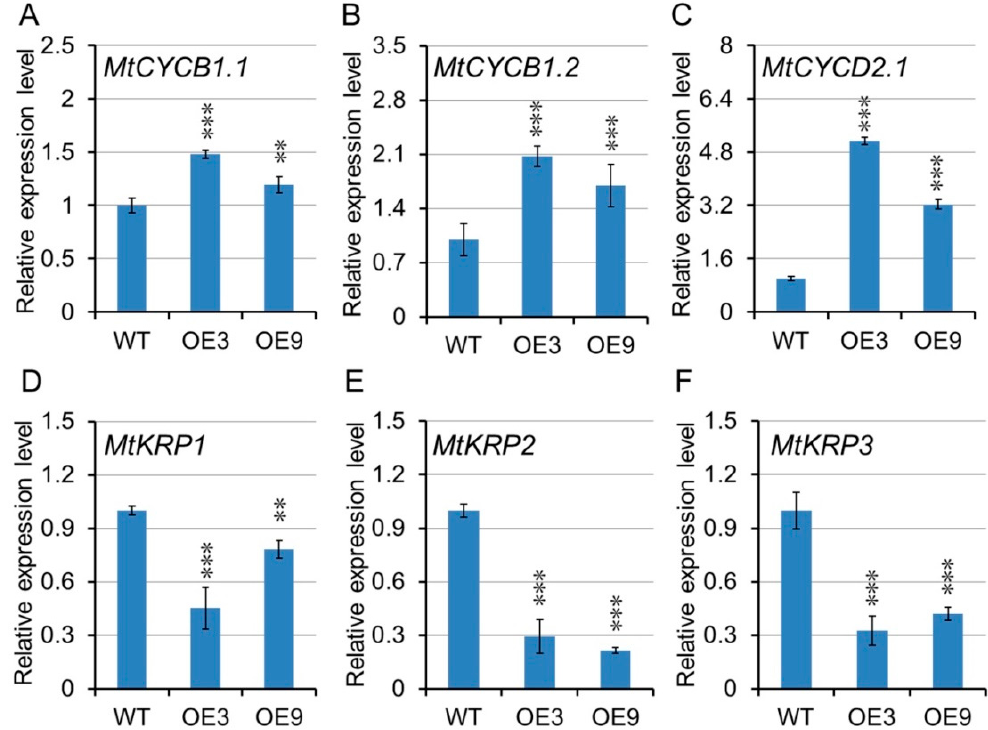
Figure 10. Expression analysis of cell development related genes in wild-type and MtGA20OX1 transgenic lines. ( A – C ) The expression of cyclindependent protein kinase genes, MtCYCB1.1 , MtCYCB1.2, and MtCYCD2.1 . ( D – F ) The expression of MtKRP1 , MtKRP2, and MtKRP3 genes. ** p < 0.01, *** p < 0.001.